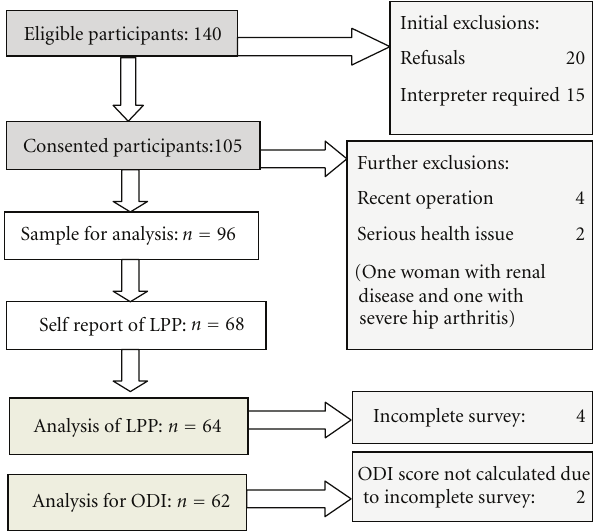
Figure 2: Flow chart of